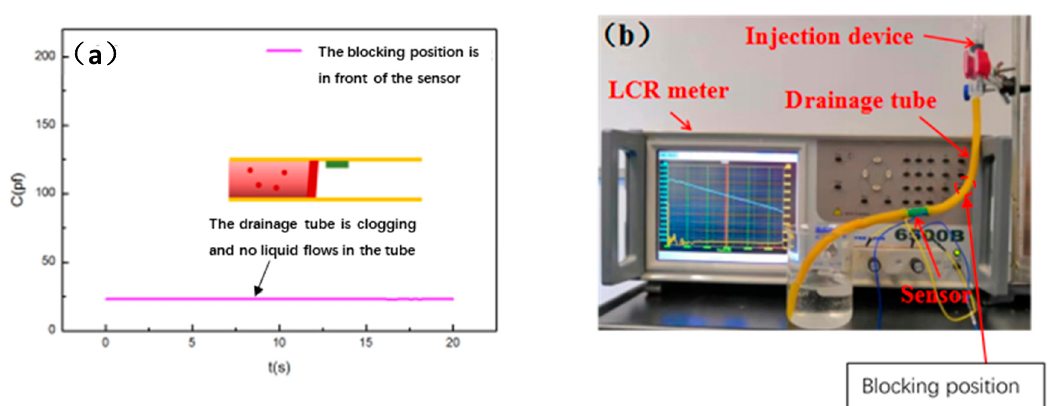
Figure 9. ( a ) The sensor’s output curve corresponding to the working state where the drainage tube is blocked and the blocking position is in front of the sensor. ( b ) Photo of blockage position in simulation experiment.